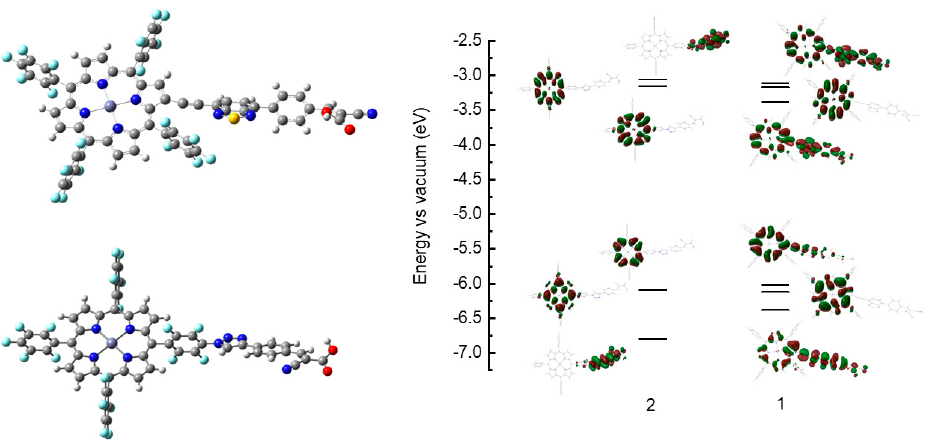
Figure 4. Left : optimized ground state geometries of the meso-porphyrin 1 and the β -substituted porphyrin 2. Right : frontier energy levels associated to their respective Kohn-Sham Orbitals (KSO) (B3LYP-6311G d,p).